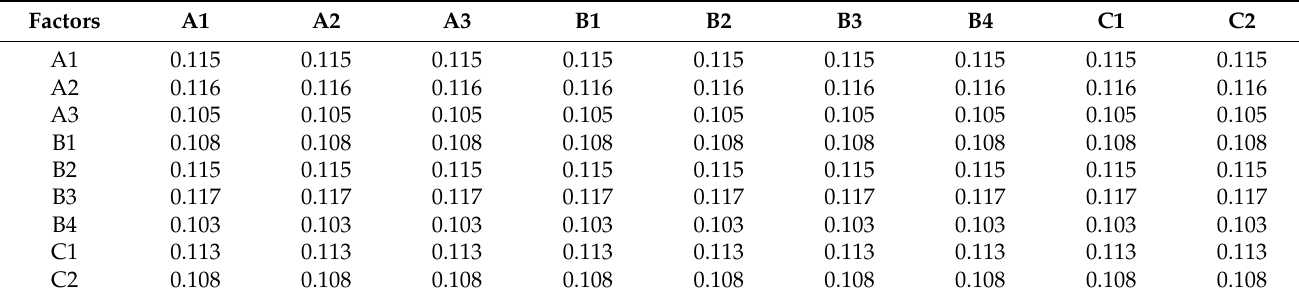
Table 7. Limit Supermatrix (W*).